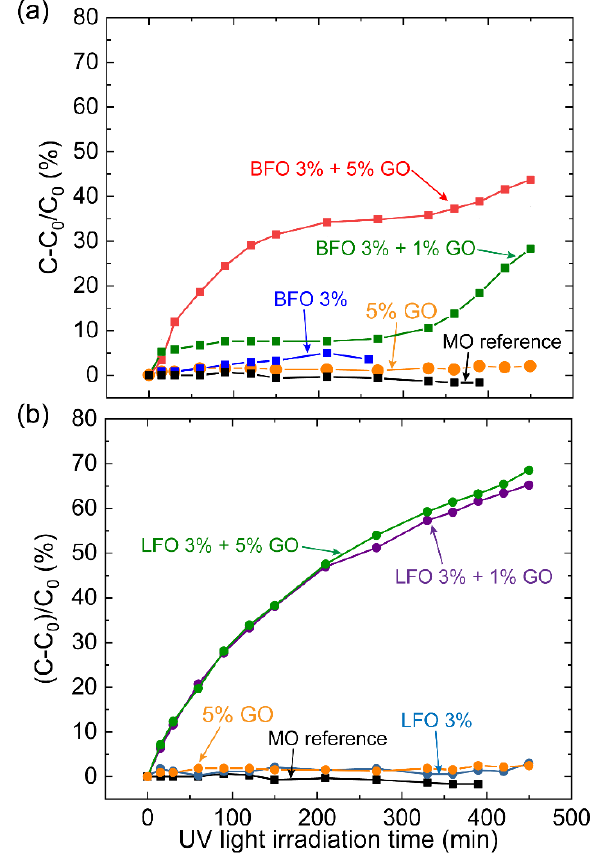
Figure 7. Self-degradation and photocatalytic degradation efficiency of MO under UV light irradiation, in the presence of ( a ) GO, BFO and BFO/rGO nanocomposite, as well as (b ) LFO and LFO/rGO nanocomposite films under UV light irradiation.